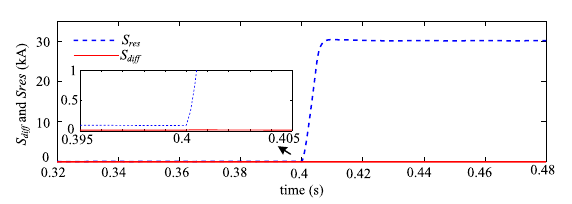
Fig. 9 Protection performance for fault at f